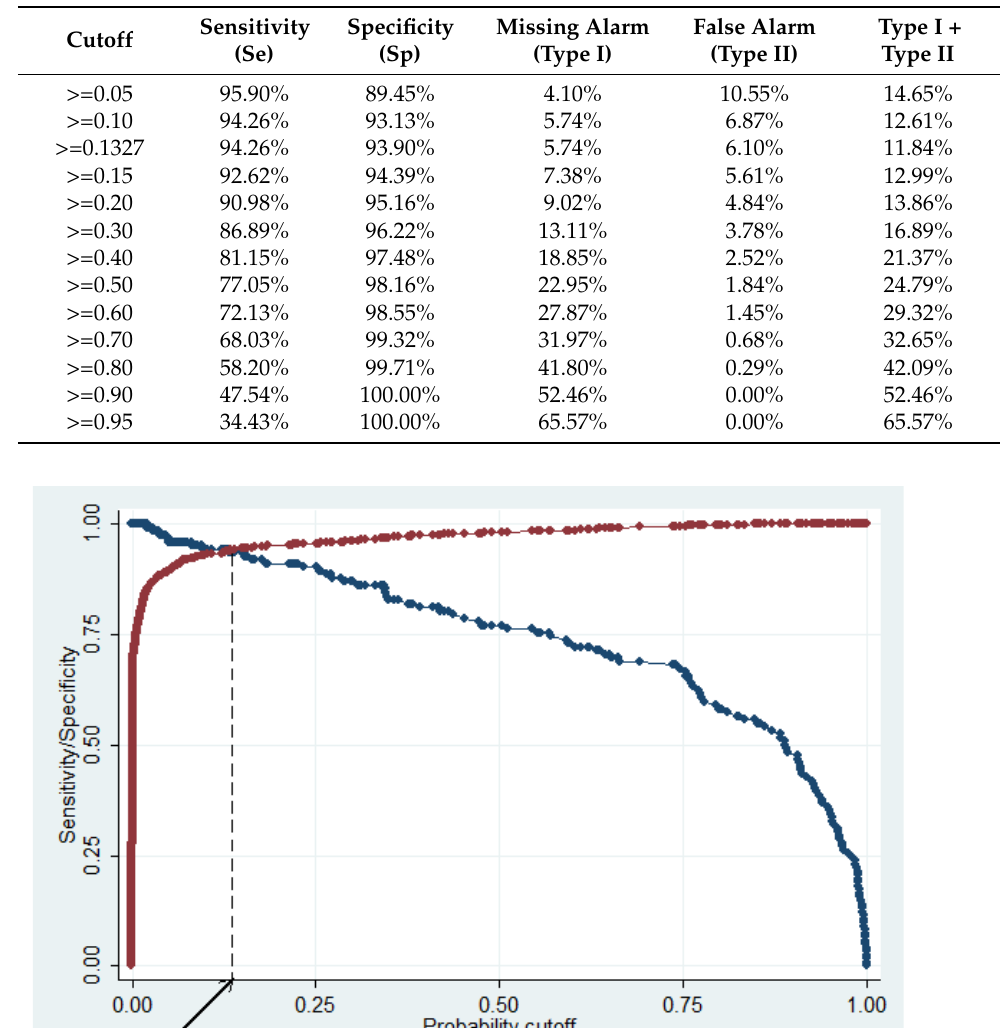
Table 6. EWS model performance with different cut-off points.